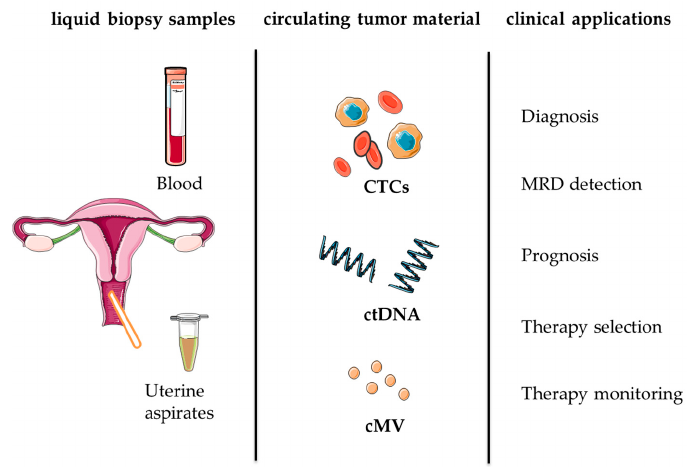
Figure 1. Liquid biopsy for personalised medicine in endometrial cancer. CTCs (circulating tumor cells), ctDNA (circulating tumor DNA), cMV (circulating microvesicles), MRD (minimal residual disease).